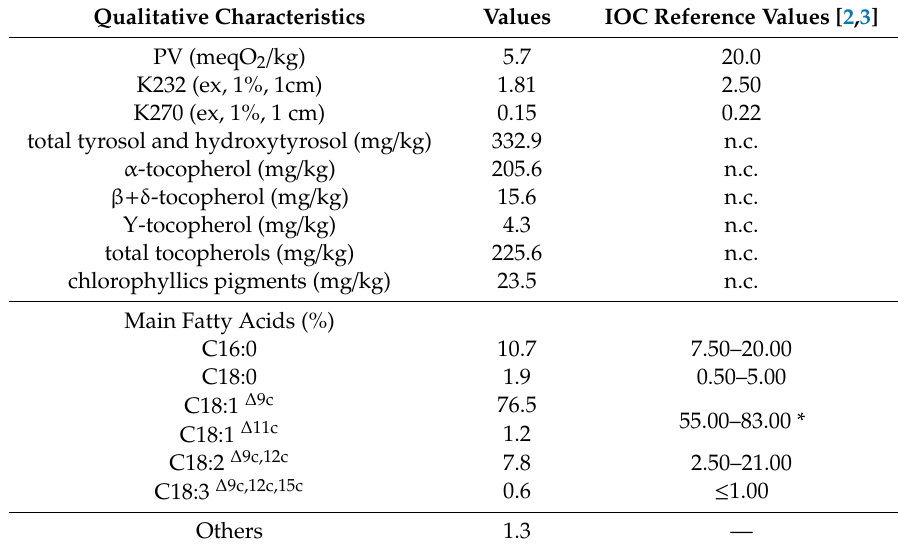
Table 1. Initial composition and characteristics of the studied extra virgin olive oil (EVOO). Qualitative